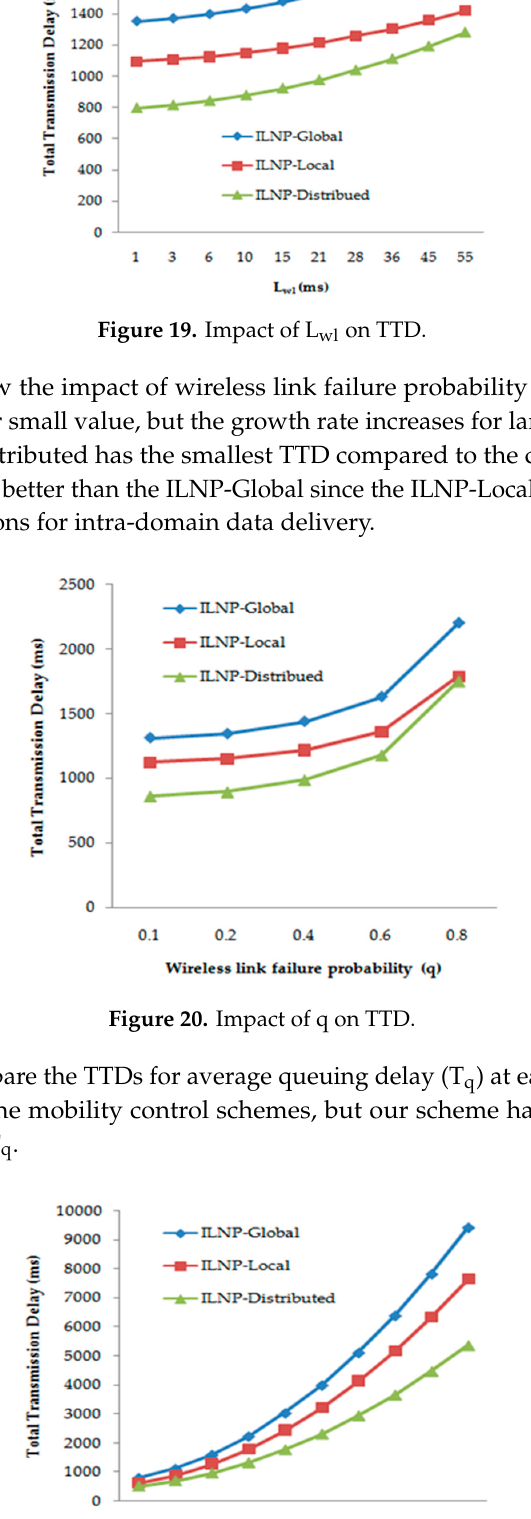
Figure 21. Impact of T q on TTD.